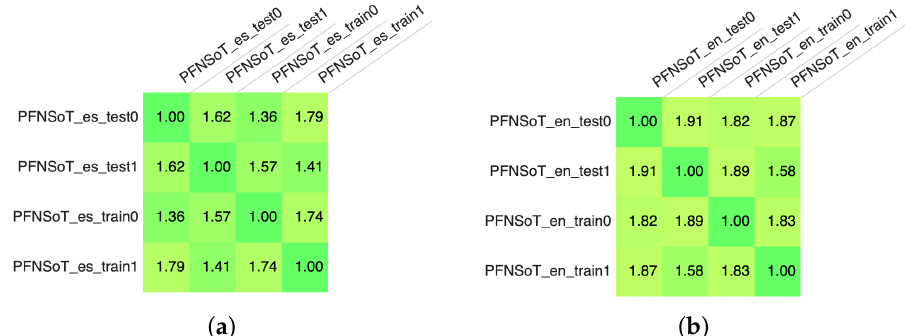
Figure 2. Comparing English and Spanish corpora: confusion matrices obtained with the chi-square test. The value 1.00 indicates identity between the compared subcorpora. The greater the value, the more different the subcorpora. ( a ) Spanish dataset. ( b ) English